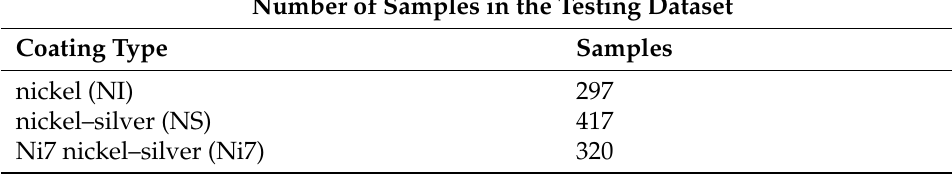
Table 2. Number of test images for each